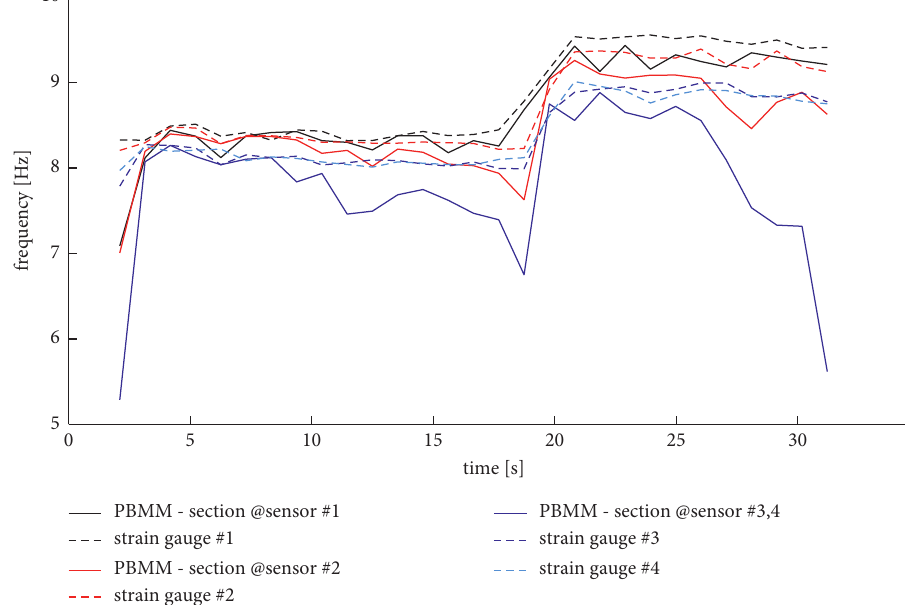
Figure 10: Identified Instantaneous Frequency time histories: PBMM (solid lines) vs. strain gauges (dashed lines), numbered as indicated in Figure